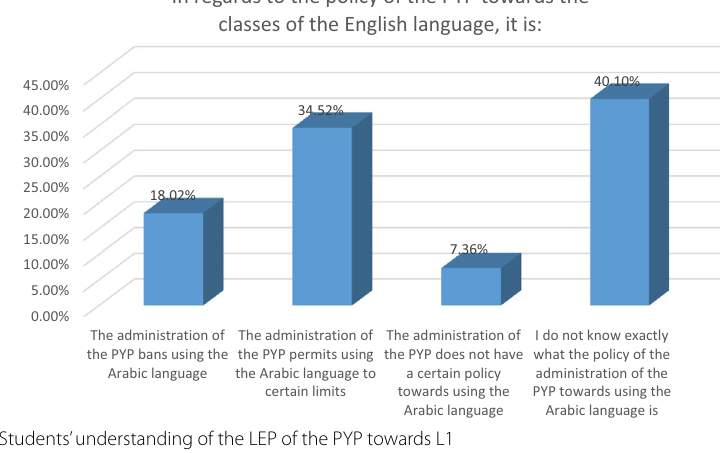
Fig. 4 Students’ understanding of the LEP of the PYP towards L1